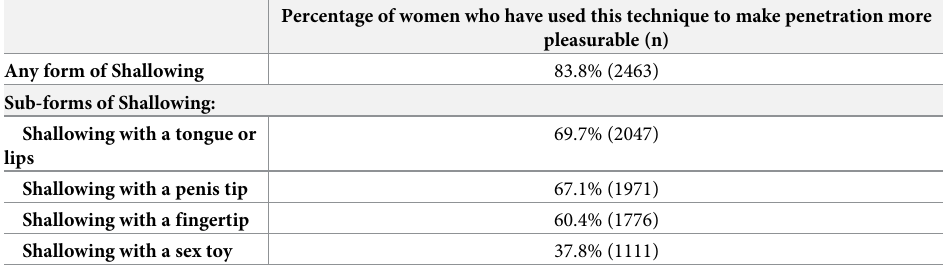
Table 4. Prevalence of use of Shallowing techniques by women to make vaginal penetration more pleasurable (N = 2939, weighted). Percentage of women who have used this technique to make penetration more pleasurable